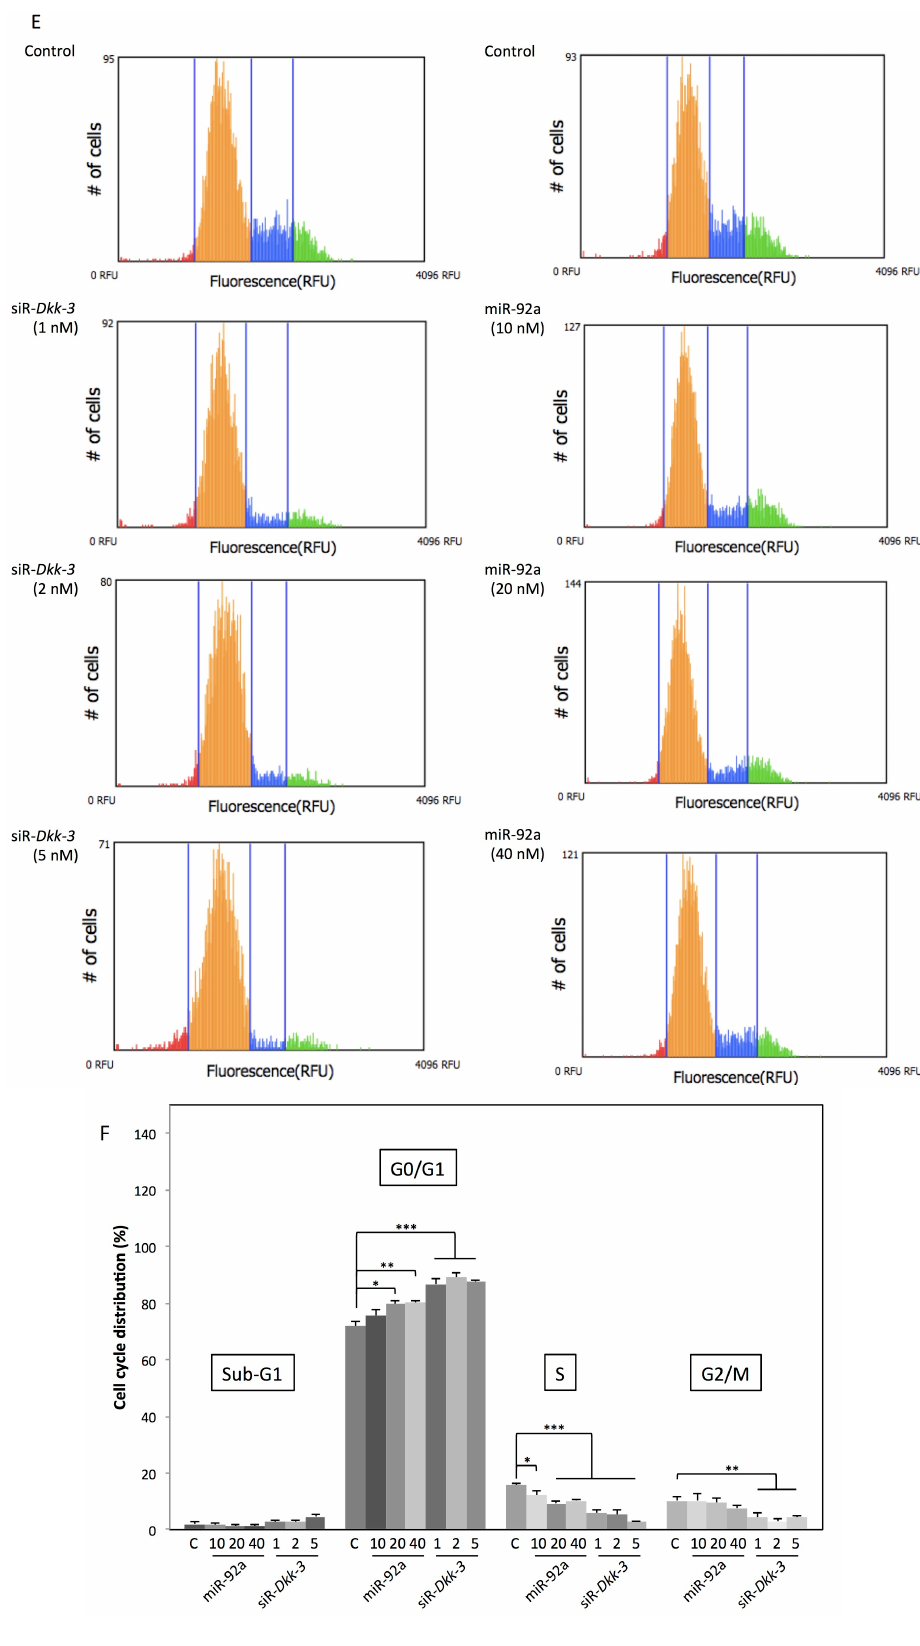
Figure 2. cont. Figure 2.